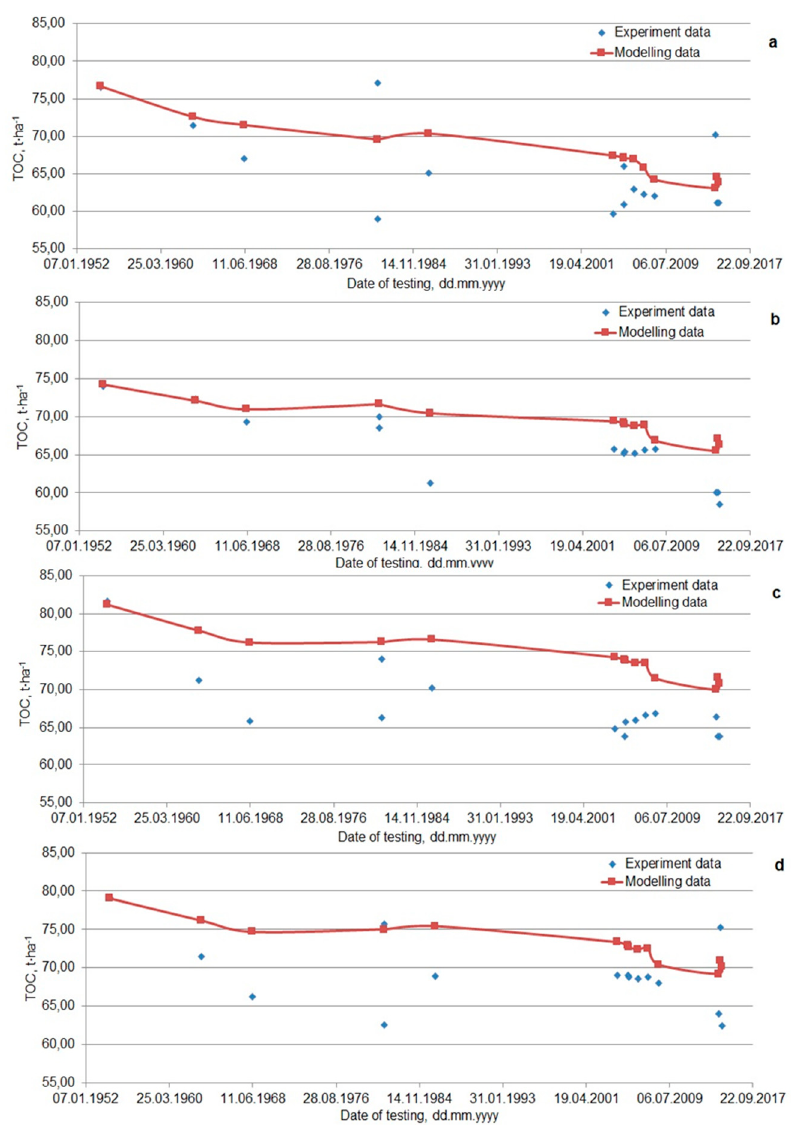
Figure 5. Dependence between experimentally determined and calculated by RothC SOC stocks in a layer of 0–20 cm of the soil of long-term experiment in the period 1954–2015 for four treatments: ( a )—control, ( b )—1NPK, ( c )—2NPK, ( d )—3NPK. Table 4. Indicators of organic carbon balance in the long-term VNIISS experiment